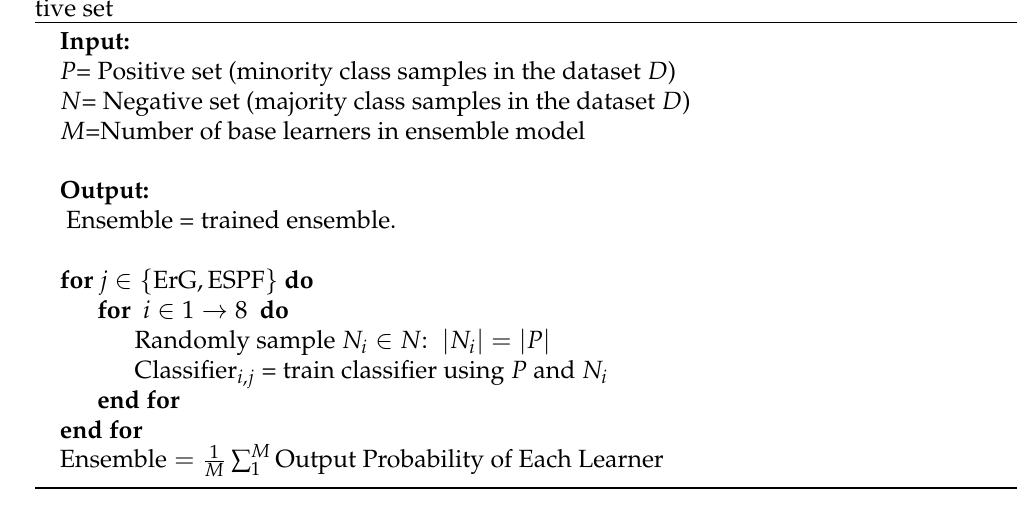
Algorithm 1 Pseudocode of ensemble of classifiers as well as undersampling the